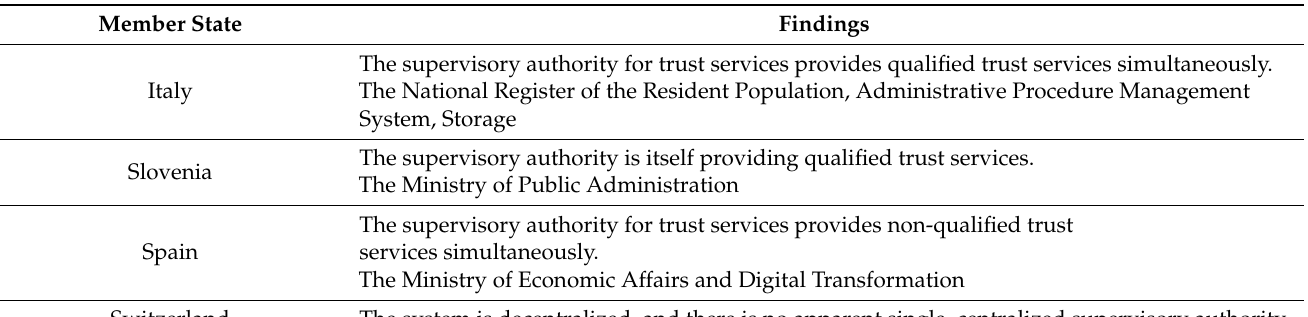
Table 1. Organizational independence for the sampled